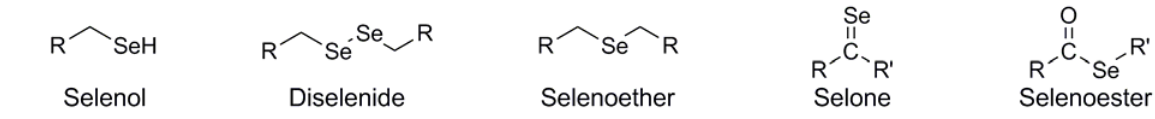
Figure 1. Various functional groups containing selenium and their nomenclature.